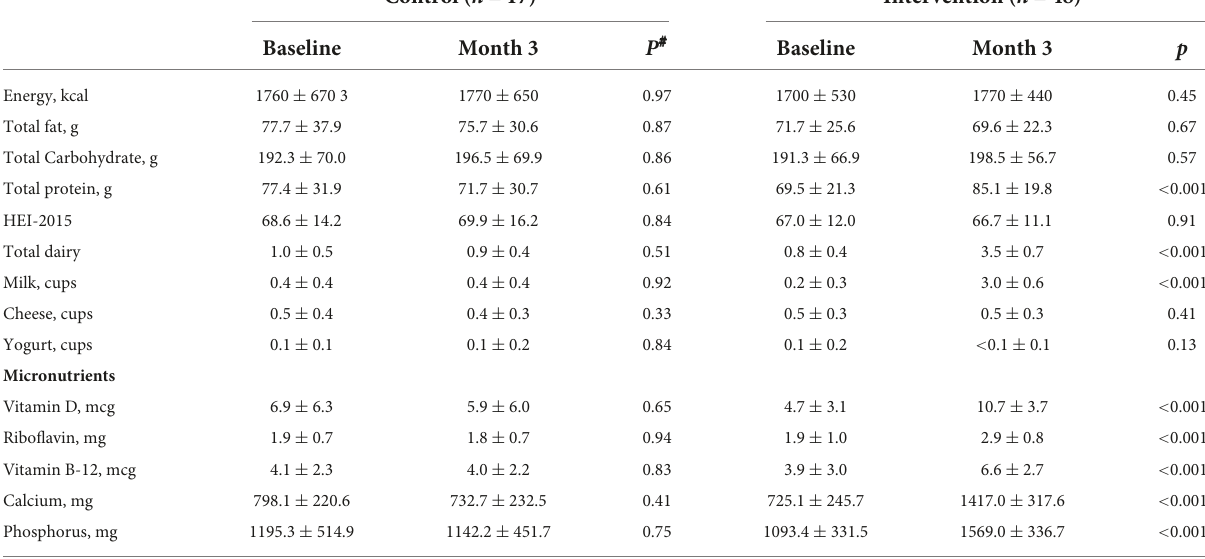
TABLE 2 Differences in dietary intake by